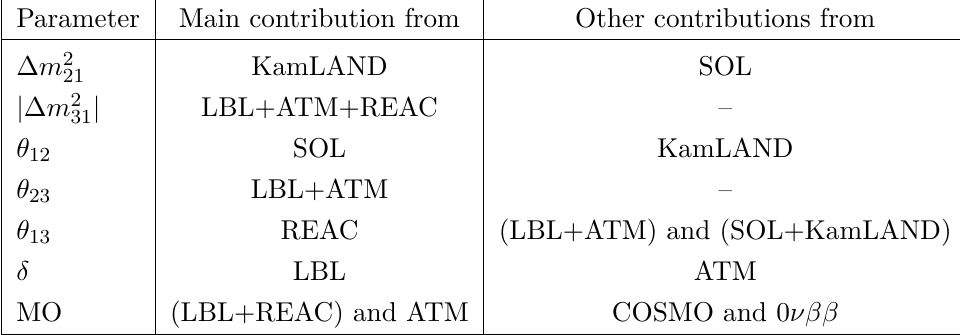
Table 1 . The main contribution to each of the oscillation parameters from the different classes of